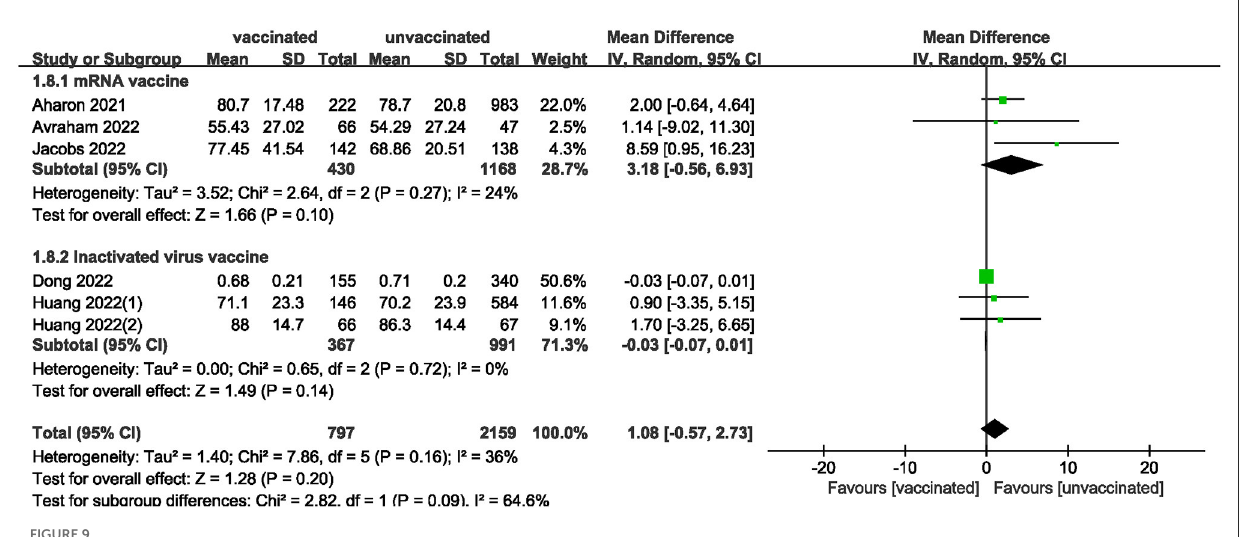
FIGURE9 Forest plot of fertilization rate. for vaccinated vs. unvaccinated.